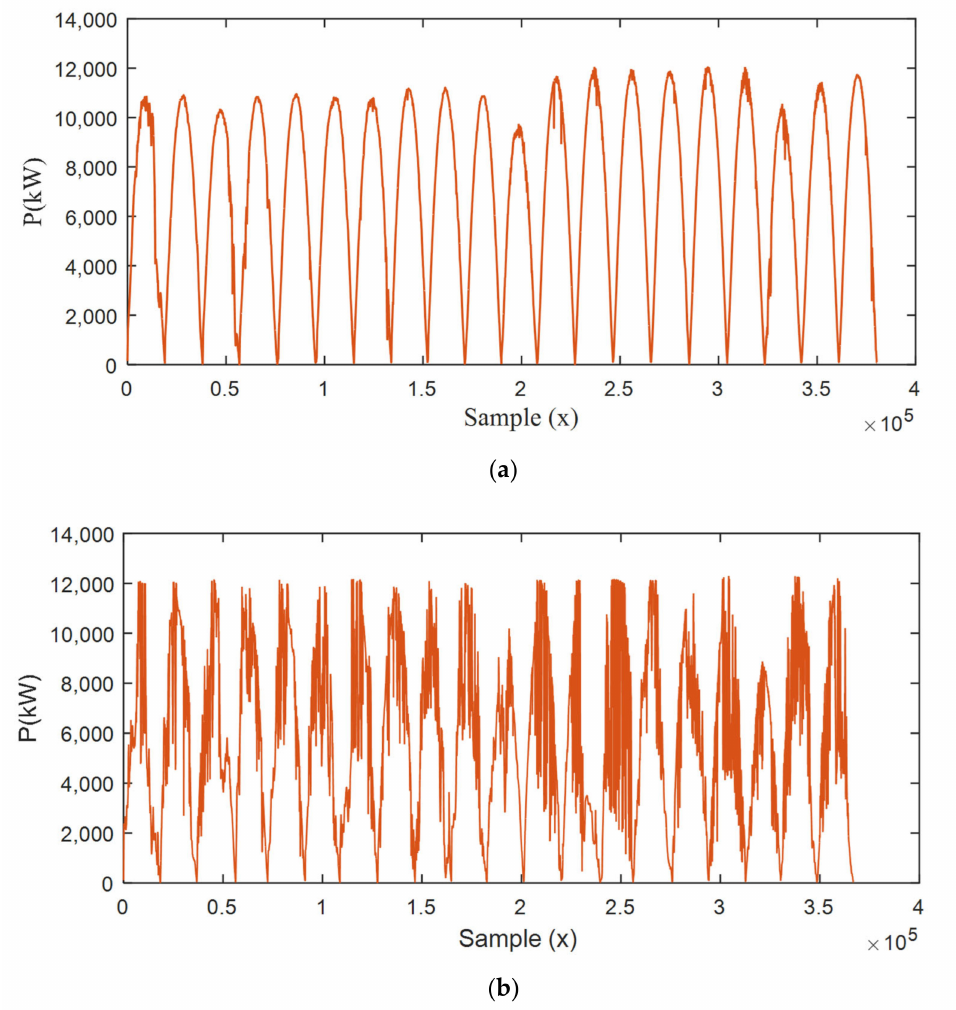
Figure 17. Two sets of data corresponding to 20 days under QSP/DSP conditions: ( a ) aggregation of 20 QSP-type PV productions per day, from September 2019 to January 2020; ( b ) aggregation of 20 DSP-type PV productions per day, from September 2019 to January